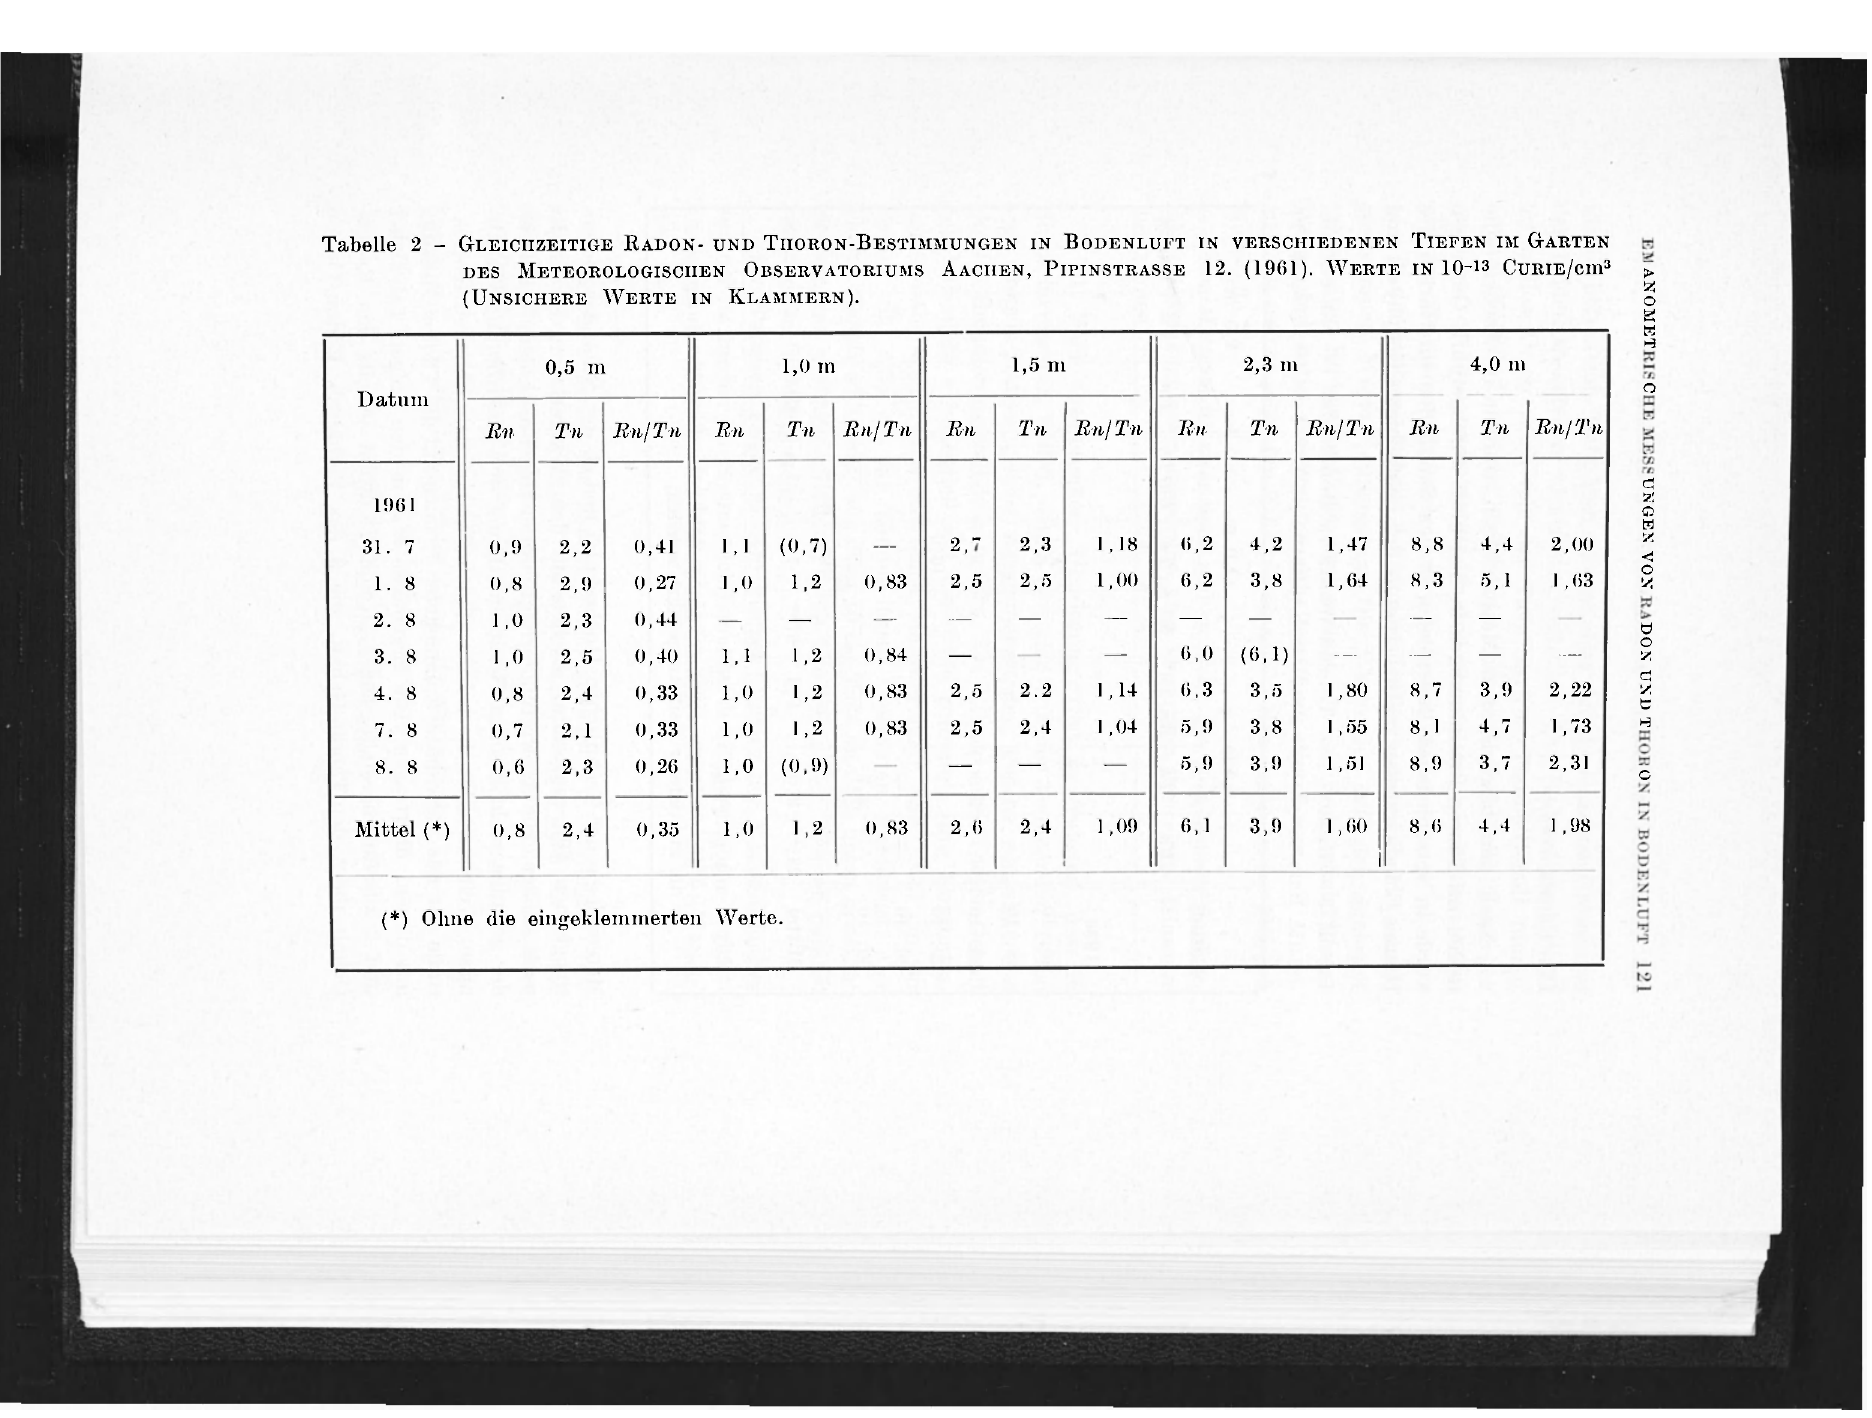
Tabelle 2 - GLEICIIZEITIGE RADON- UND TIIORON-BESTIMMUNGEN IN BODENLUFT IN VERSCHIEDENEN TIEFEN IM GARTEN DES METEOROLOGISCIIEN OBSERVATORIUMS AACIIEN,